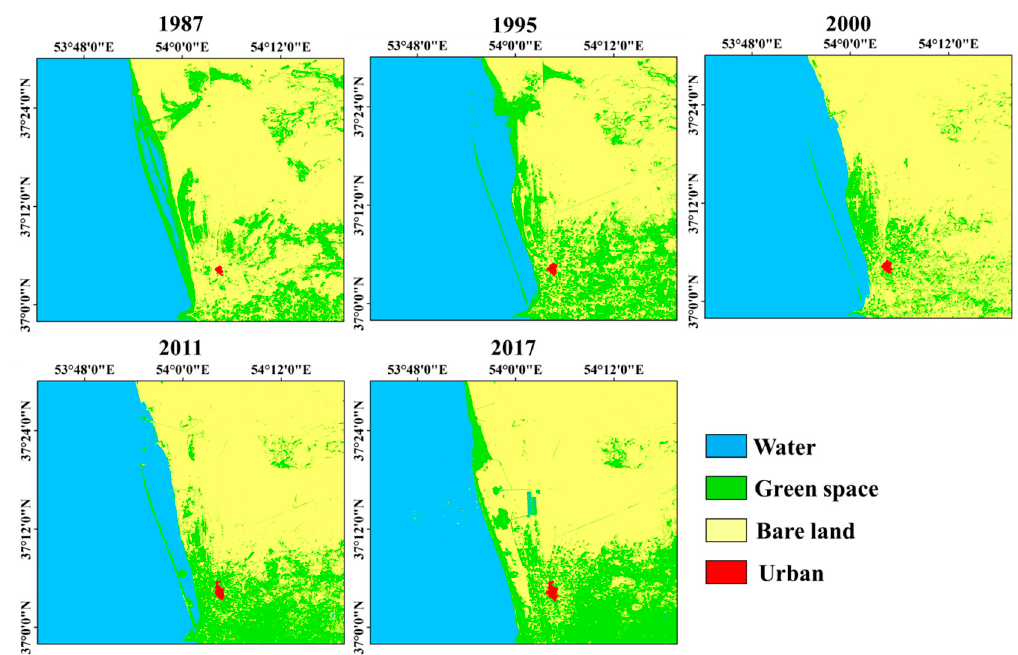
Figure 11. Land cover maps of the study area.